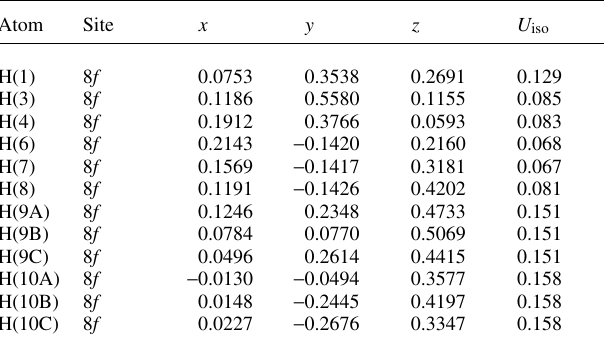
Table 2. Atomic coordinates and displacement parameters (in Å 2 ) .